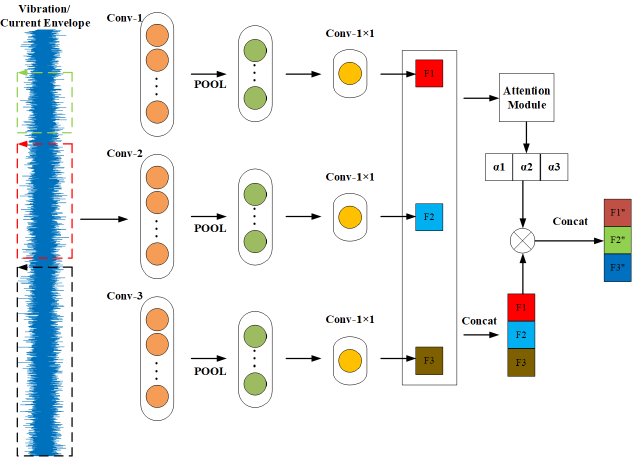
Figure 4. Multi-scale feature extraction module based on attention mechanism (MFBAM).